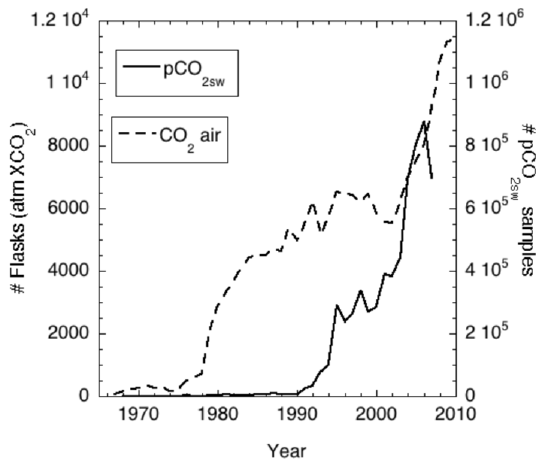
Fig. 1. Tabulation of the number of air CO 2 samples (dashed line, left axis) and surface water p CO 2 samples (solid line, right axis) taken per year. The tabulations for air samples are from NOAA/ESRL/GMD (courtesy T. Conway, NOAA/Earth System Research Laboratory/Global Monitoring Division) and the num- bers of p CO 2 surface water samples are from the SOCAT (Surface Ocean CO 2 Atlas) database (Pfeil et al., 2012). Note the hundred- fold difference in the scales of the left and right